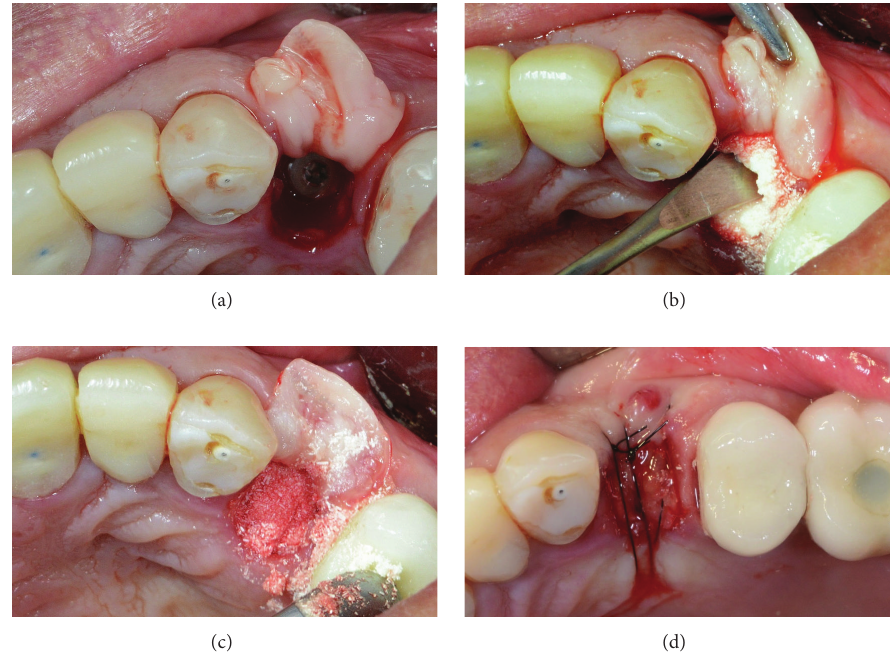
Figure 3: Placement of a single 3DP/AM titanium dental implant in a postextraction socket of the posterior maxilla: surgical phases. (a) The biological membrane is ready to be sutured for protecting the socket. (b) Socket preservation with particulate bone grafts. (c) The socket is completely filled with particulate bone grafts before the sutures. (d)